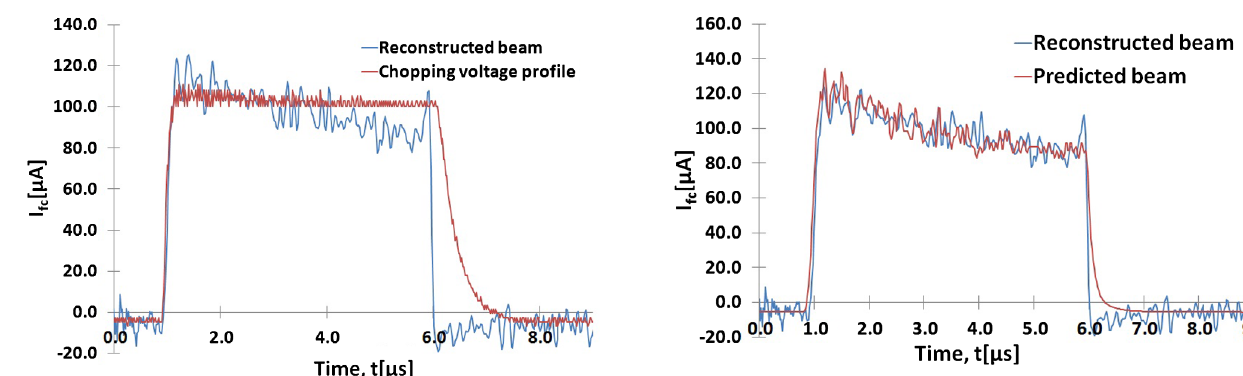
FIG. 19. Reconstructed beam pulse profile with a duration of 5 (cid:1) s and the chopping voltage profile in arbitrary units.